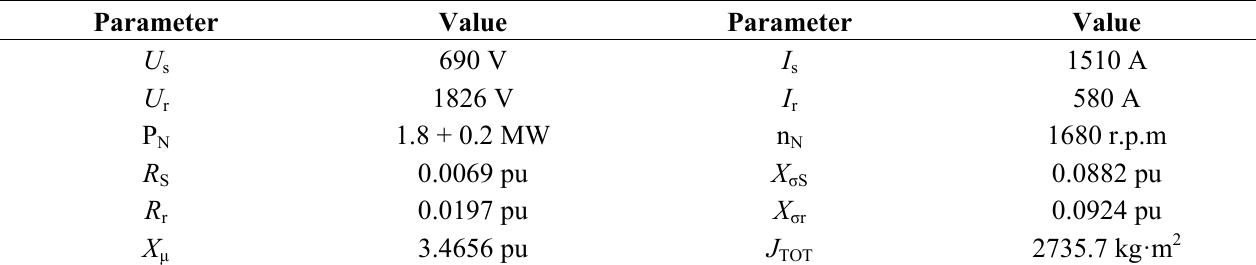
Table 1. Specifications of the simulated commercial DFIG.